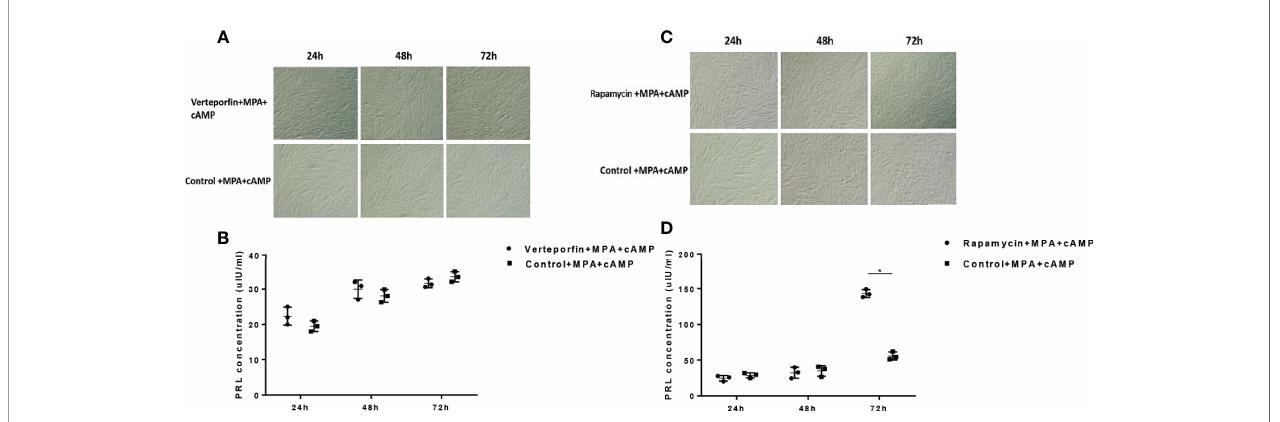
FIGURE 6 | Effects of Vertepor fi n and Rapamycin treatments on the in vitro decidualization of ESCs. Compared to the cultured control group, the morphology of ESCs in the Vertepor fi n treatment group had no obvious decidual changes after 24 h, 48 h, and 72 h of in vitro induction (A) . ELISA results suggested that there was no signi fi cant difference in the dPRL levels in the culture medium of ESCs in the groups of Vertepor fi n and the control group after 24 h, 48 h, and 72 h of decidualization ( p > 0.05) (B) . After 24 h and 48 h of in vitro induction, some of the ESCs in the Rapamycin-treated and control groups were rounded and enlarged. Seventy-two hours after in vitro induction, compared with the control group, the Rapamycin-treated ESCs showed obvious decidual-like changes (C) . After 72 h of decidualization, the dPRL level was signi fi cantly increased in the cell culture medium of the Rapamycin group compared with that of the control group ( p < 0.05) (D) . *p <